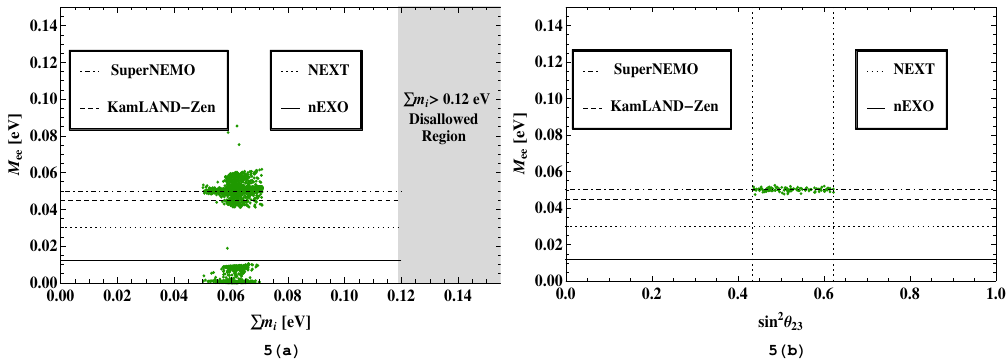
Figure 5 . Variation of Effective Majorana mass | M ee | with sum of neutrino masses P m i for normal hierarchy (figure 5(a)) and with sin 2 θ (figure 5(b)). The horizontal lines are the sensitivity reach 23 of 0 νββ decay experiments. The grey shaded region is disallowed by cosmological bound on sum of neutrino masses [60, 61].